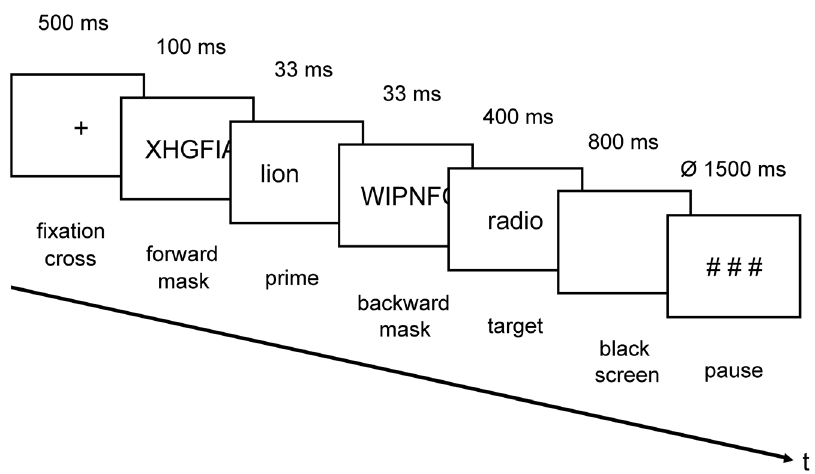
Figure 2. Experimental procedure of the masked feature-priming task.